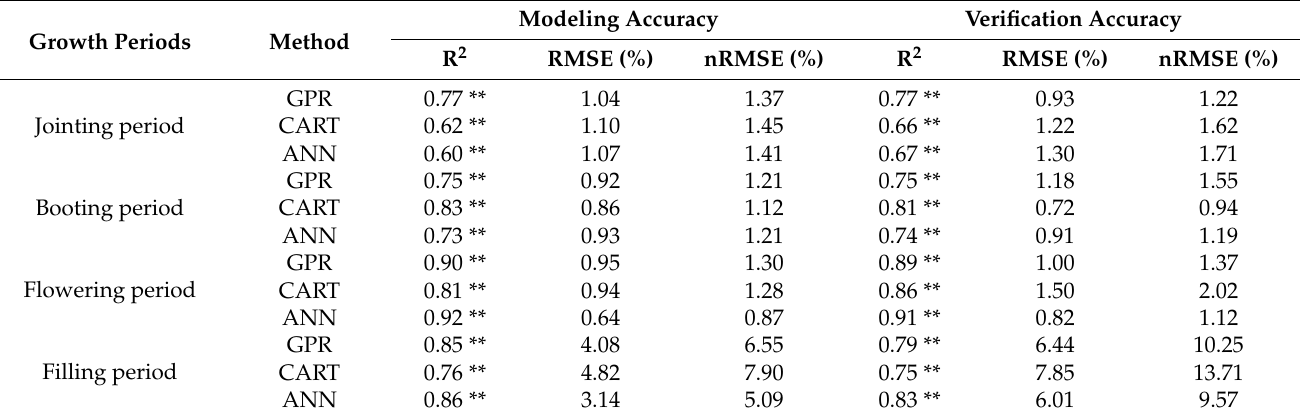
Table 4. The LWC estimation results obtained by using differential spectrum and wavelet coefficients combined with GPR, CART, and ANN for different growth